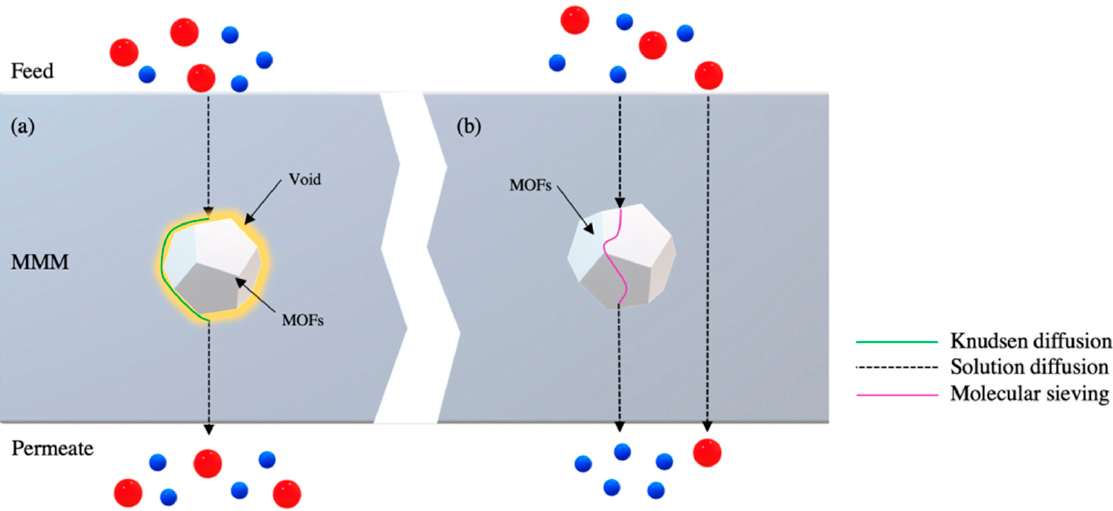
Figure 1. Transport mechanisms for gas transport through mixed matrix membrane with; ( a ) interfacial defect, ( b ) defect free layer [26] .